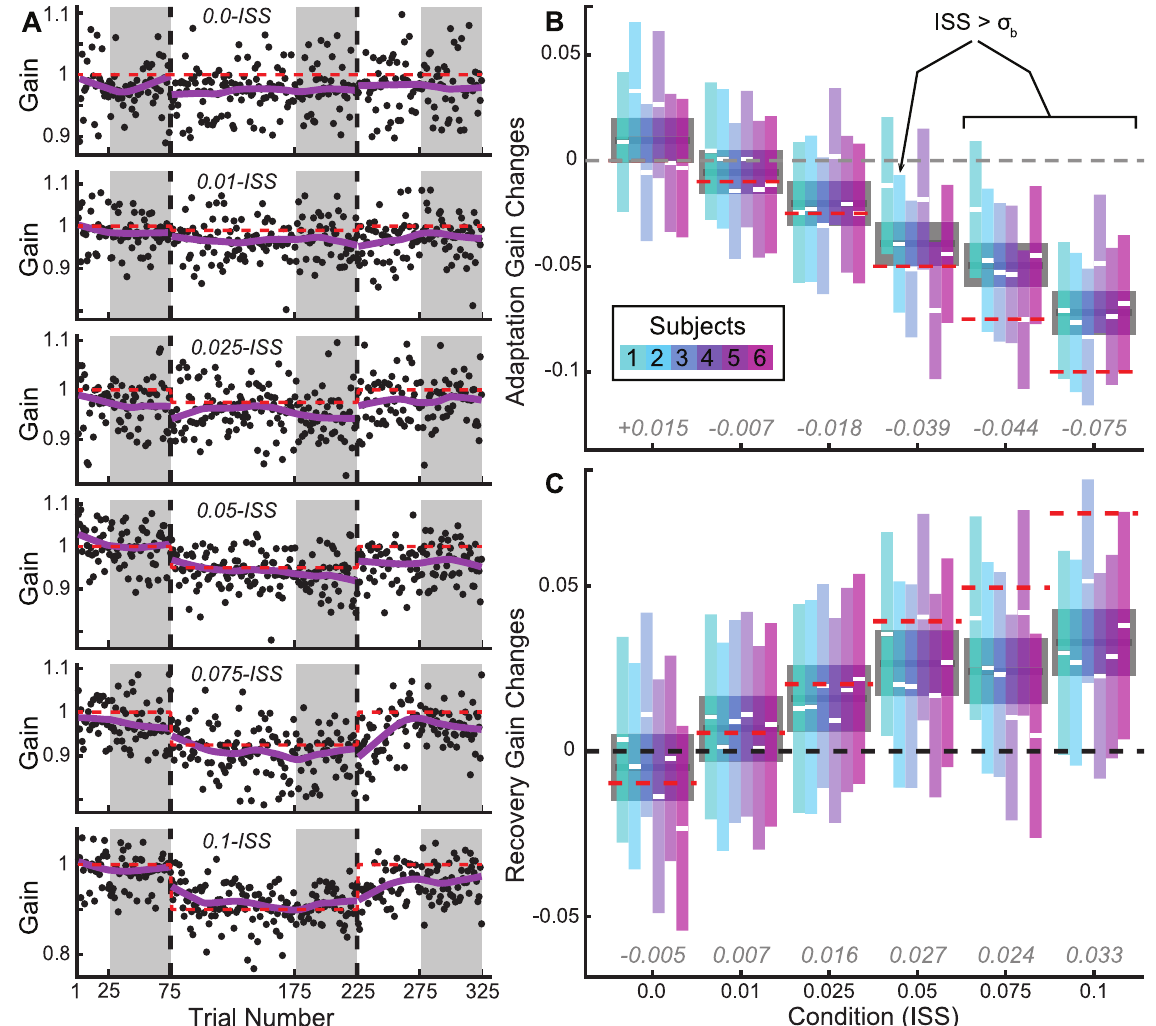
Figure 2. Gain adaptation and recovery. A. Raw data from an example subject. Primary saccade gains (black dots) are plotted versus trial numbers for each ISS condition, with 0.0-ISS at top, down to 0.1 at bottom. Red dashed lines indicate the final target position, and purple traces are robust lowess smooths, this color indicates the example subject’s data, also in purple, at right (subject 5), in B and C. Gray shaded regions indicate those used to calculate adaptation and recovery magnitudes plotted in B, and C. For the details of this procedure, see Methods. Briefly, adaptation was calculated by the difference between the means of the final 50 trials of baseline and adapt phase using the Tukey-Kramer method after an ANOVA. B. Magnitude of adaptation across and within subjects. Gray boxes and dark gray line segments in background represent across-subjects adaptation, while colored boxes and white line-segments represent individual subject adaptation (mean 6 95% CI: Confidence Interval; box colors correspond to subjects as indicated in legend). Dashed grey line represents 0 adaptation, and may be used to determine significance by comparison with group or individual CIs (non-overlapping meaning significant adaptation). Red dashed lines represent ISS values (in gain units), and grey italic text above axis indicates mean across-subjects adaptation magnitude. We have also indicated those cases in which the ISS value was greater than the subject’s baseline variability ( s b ) in that session. C. Magnitude of recovery across and within subjects. Conventions as in B, except red dashed line- segments now indicate (sign-reversed) adaptation magnitude as calculated above (in A) and grey italic text above axis now indicates the magnitude of recovery across subjects. Black dashed line represents 0 recovery, and may again be used to determine significance by comparison with a CI of interest.